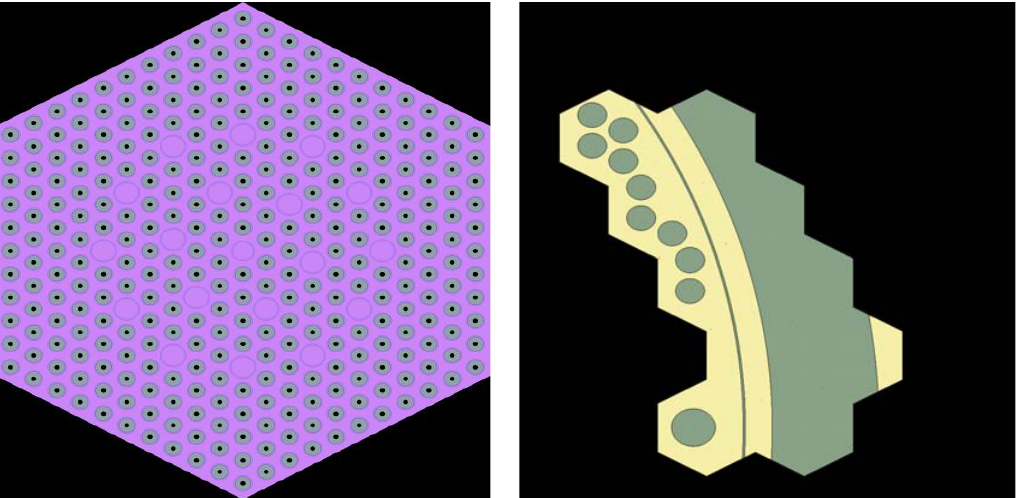
Figure 4: single FA model (left), cell reflector model